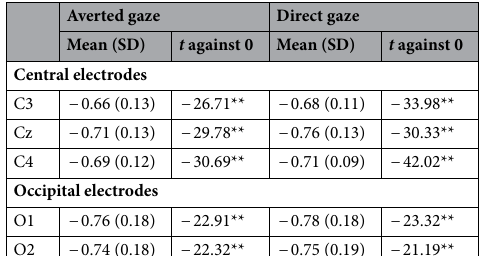
Averted gaze Direct